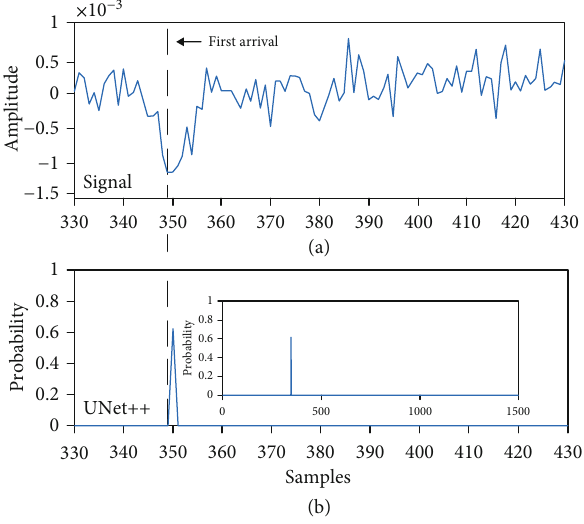
Figure 12: First-arrival picking result of the forward modeling signal with -8-dB Gaussian noise added. (a) Local ampli fi cation of the signal waveform in the range from 330ms to 430ms; (b) the picking result in the range from 330ms to 430 ms obtained by the